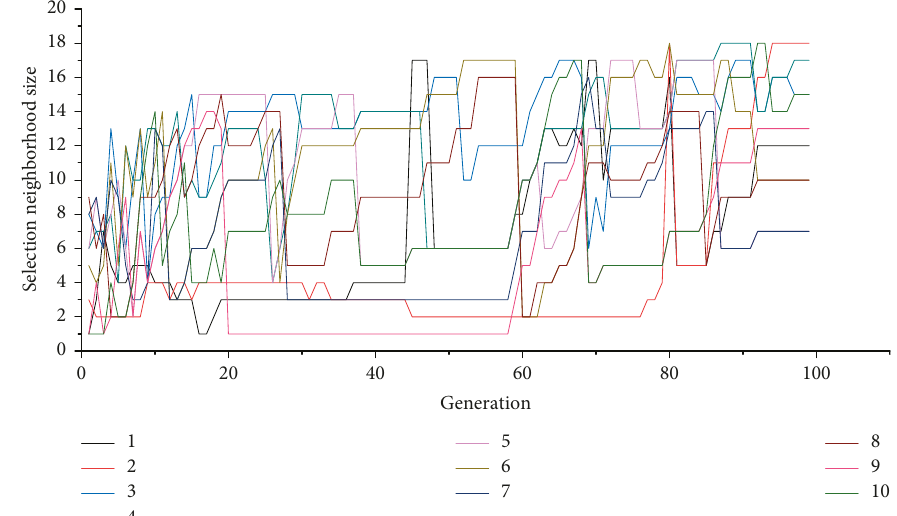
Figure 10: Variation of selection neighhorhood sizes for individuals 1 to